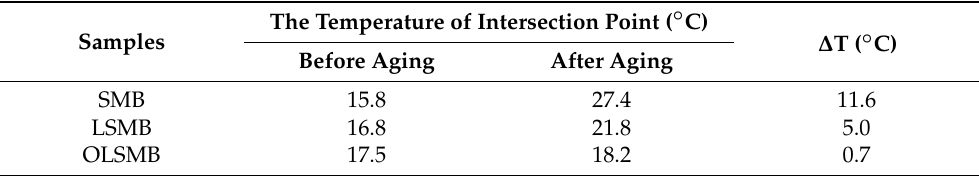
Figure 5. G ′ and G ″ vs. temperature from ( a ) − 10 to 30 °C and ( b ) 14 to 30 °C and the cross points Figure 5. G (cid:48) and G (cid:48)(cid:48) vs. temperature from ( a ) − 10 to 30 ◦ C and ( b ) 14 to 30 ◦ C and the cross points for SMB, LSMB and OLSMB after aging. for SMB, LSMB and OLSMB after aging. Table 3. The temperature of intersection points of all SMB Table 3. The temperature of intersection points of all SMB samples.